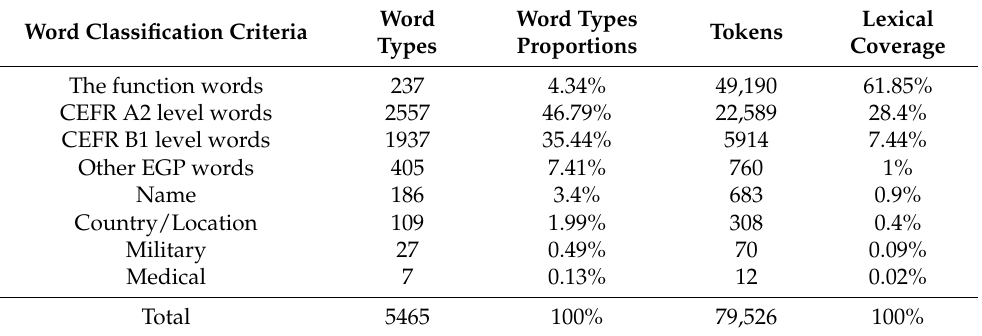
Table 1. Lexical composition of the target